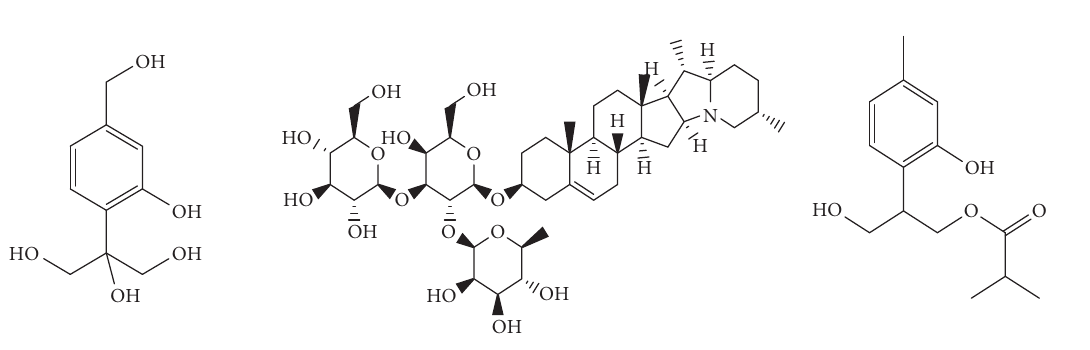
Figure 1: Relevant natural herbicidal